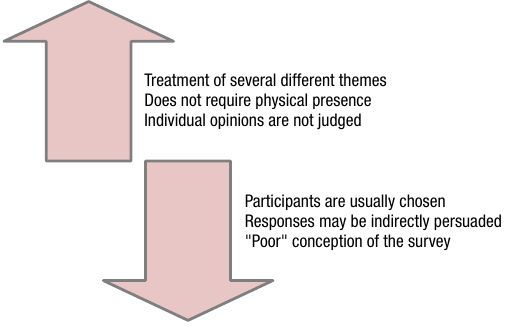
Fig. 4. Pros and cons of the Delphi technique Source : Ferreira et al. (2013,